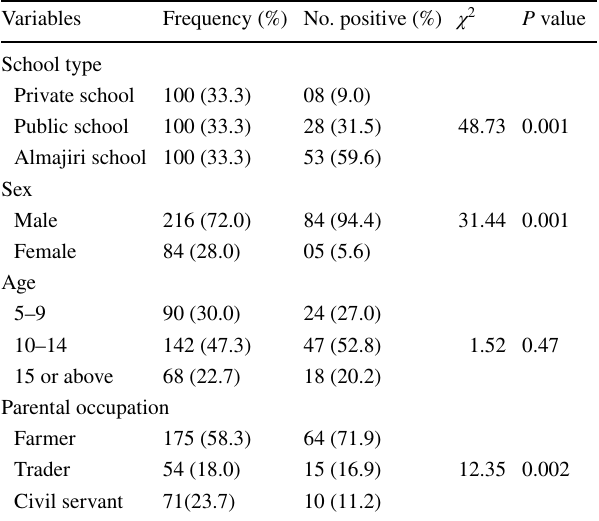
Table 1 Socio-demographic features of the prevalence of schistoso- miasis by school type, sex, age, and parental occupation in the study area